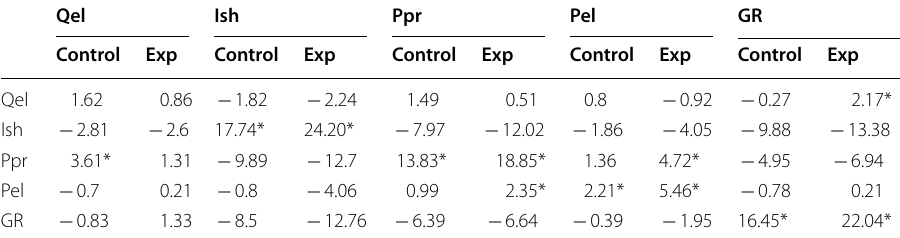
Table 5 The adjusted residuals Z scores under two